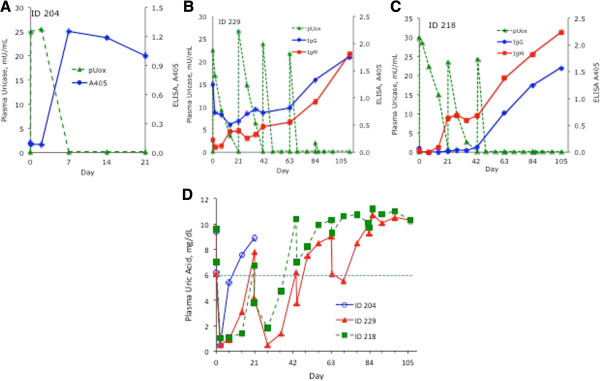
Evolution of Ab to pegloticase and relation to pUox and pUA in three patients with a transient response to treatment with pegloticase. (A-C) Change during treatment in pUox (left vertical axis) and in the ELISAs for Ab to pegloticase (right vertical axis). (D) Change during treatment in pUA for the same three patients.